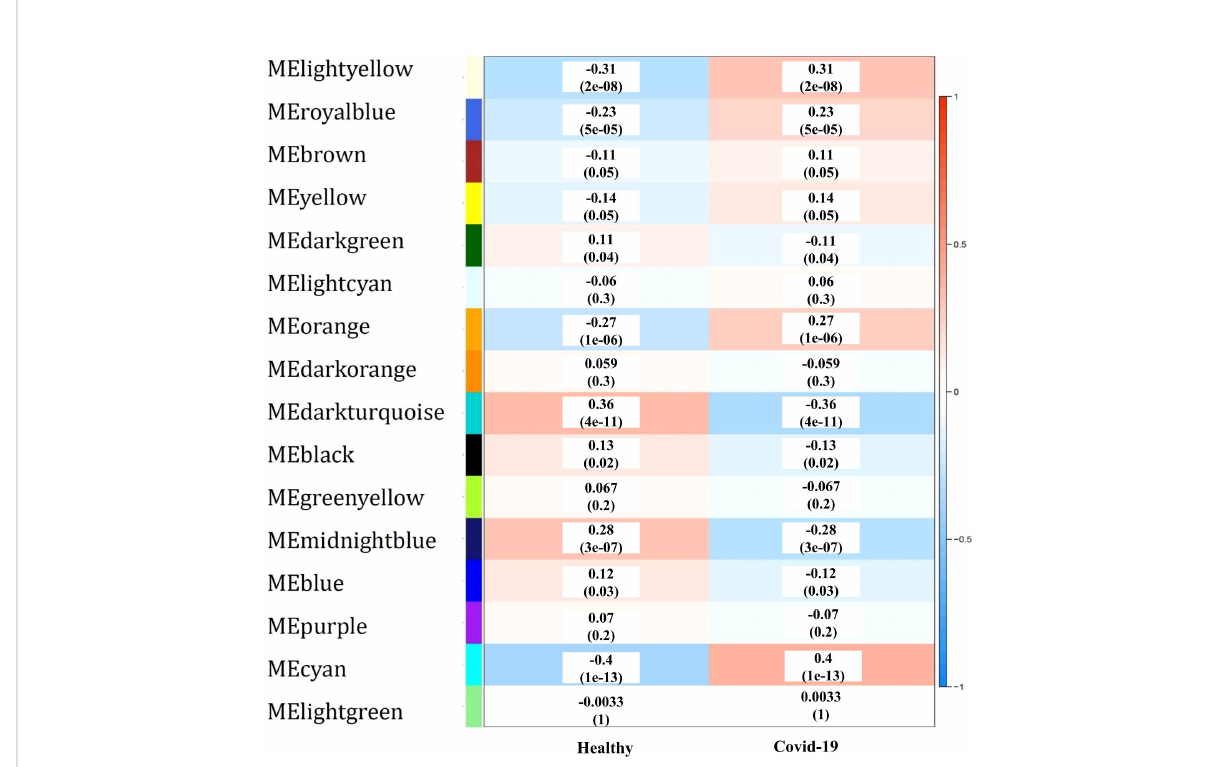
FIGURE 3 The module-trait relationships, in which the correlation and p-value between modules (vertical axis) and each condition (horizontal axis) are speci fi ed.